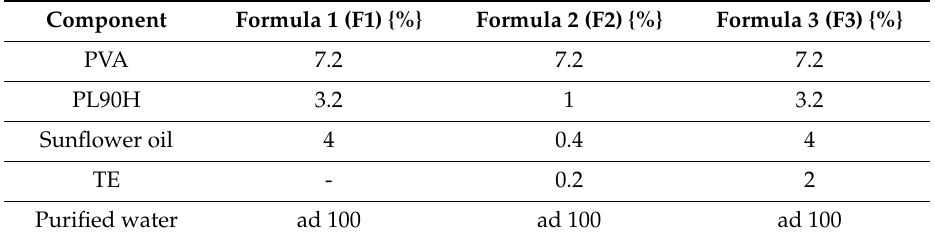
Table 3. Final composition (wt.%) of formulation blends for